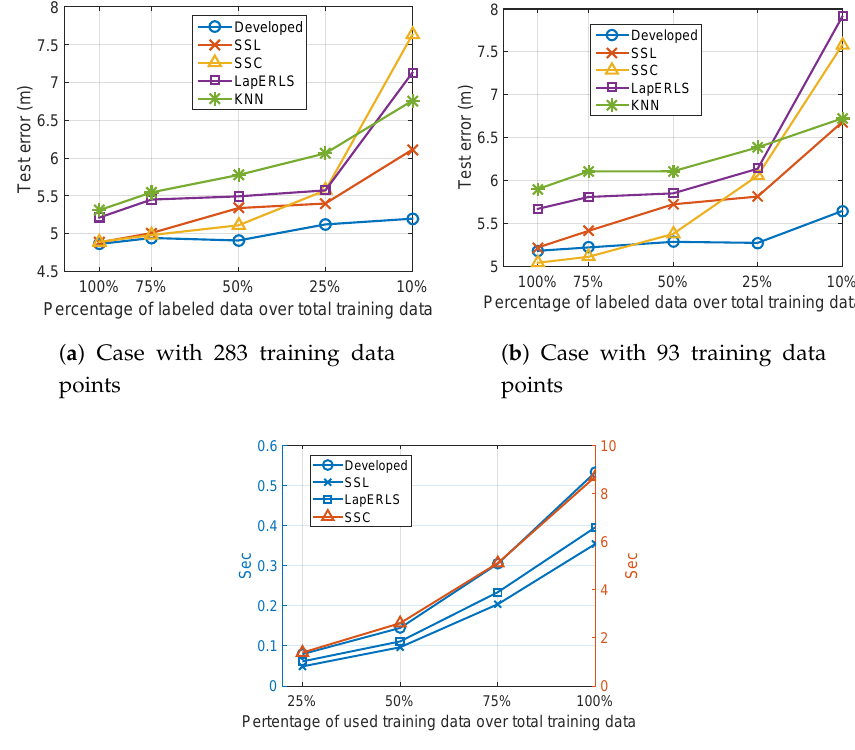
Figure 4. Localization results of the compared algorithms when we vary the percentage of the labeled training data: ( a ) case with 283 training data points, ( b ) case with 93 training data points, and ( c ) running time of the compared semisupervised algorithms for pseudolabeling with respect to the percentage of used training